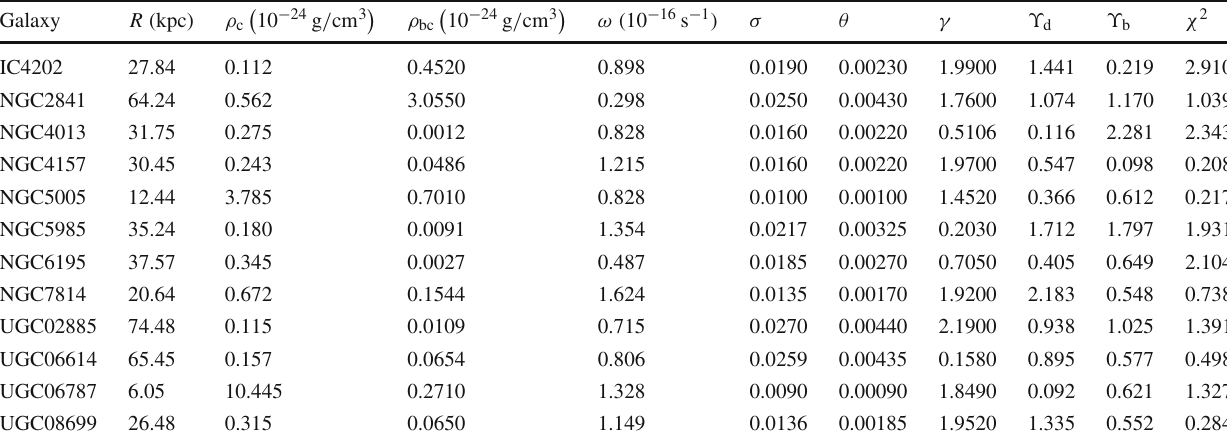
Table 2 Optimal fits for 12 galaxies from the SPARC database with bulge velocities